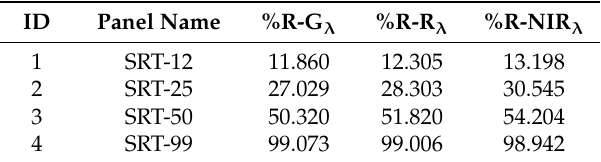
Table 4. Spectralon multi-step target ID and mean spectral reflectance values 1 .